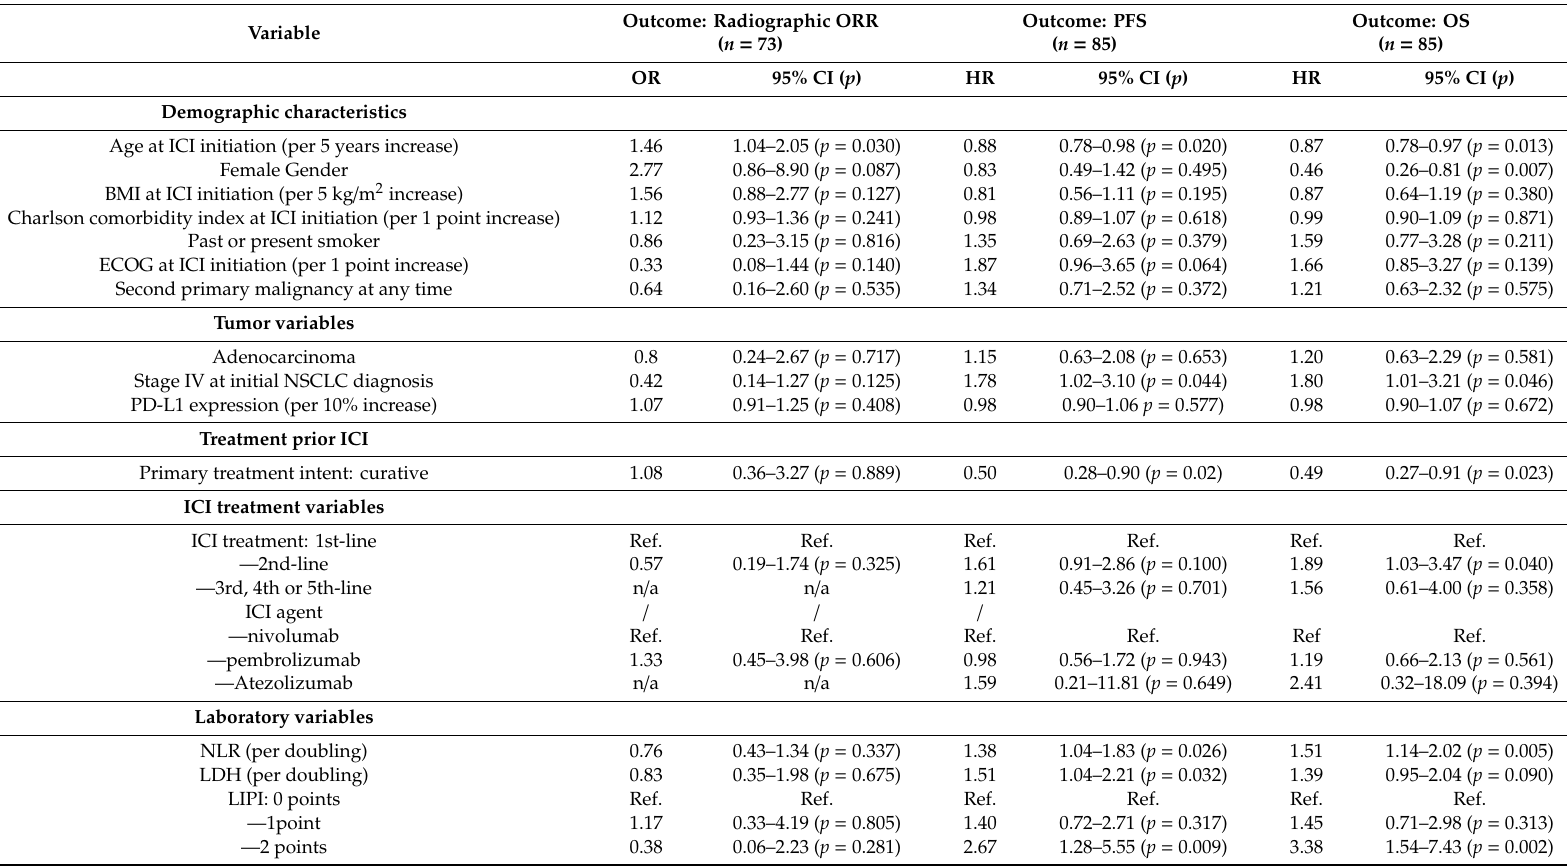
Table 2. Univariable predictors of treatment outcome in the Graz